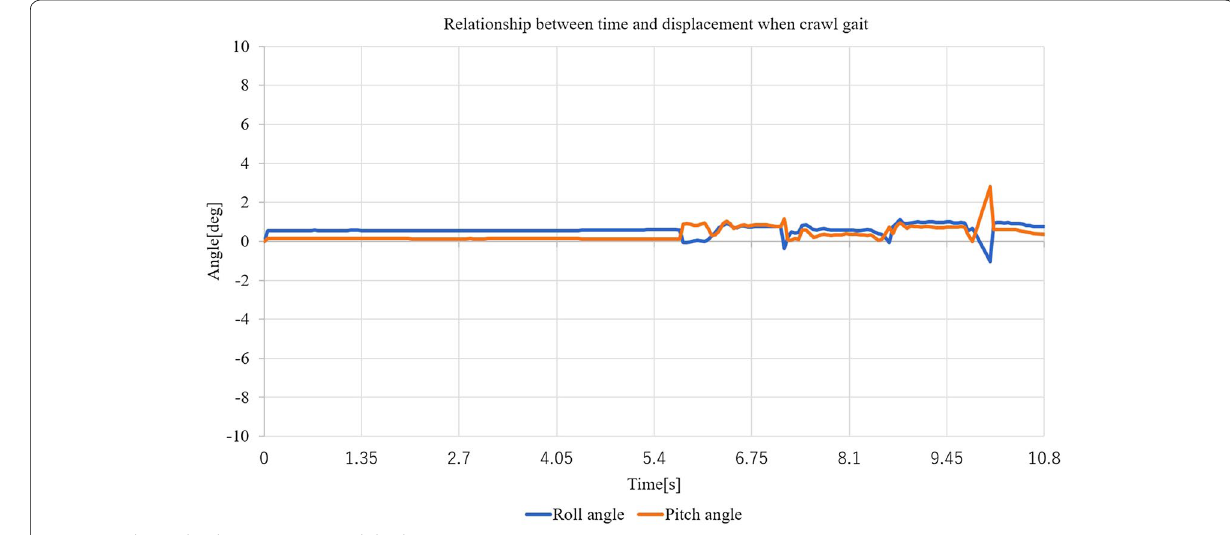
Fig. 14 Relationship between time and displacement